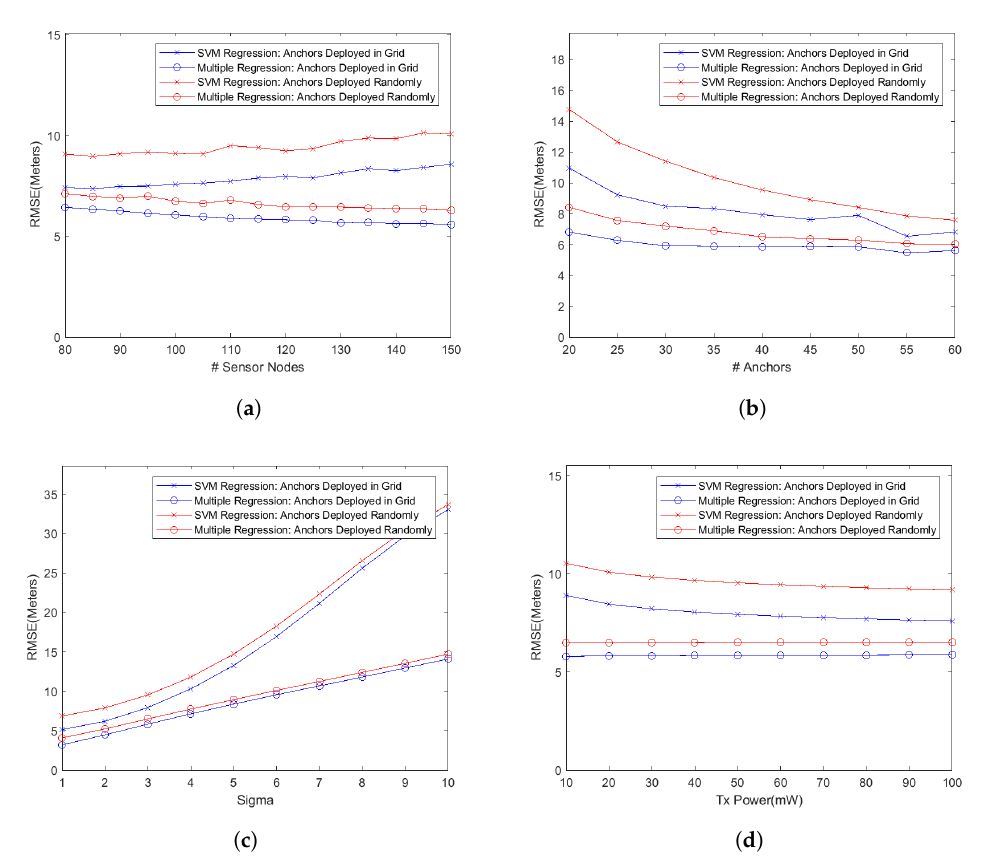
Figure 3. Impact of deploying anchor nodes randomly versus along a grid on the performance metric (i.e., localization accuracy) for extended feature set regression